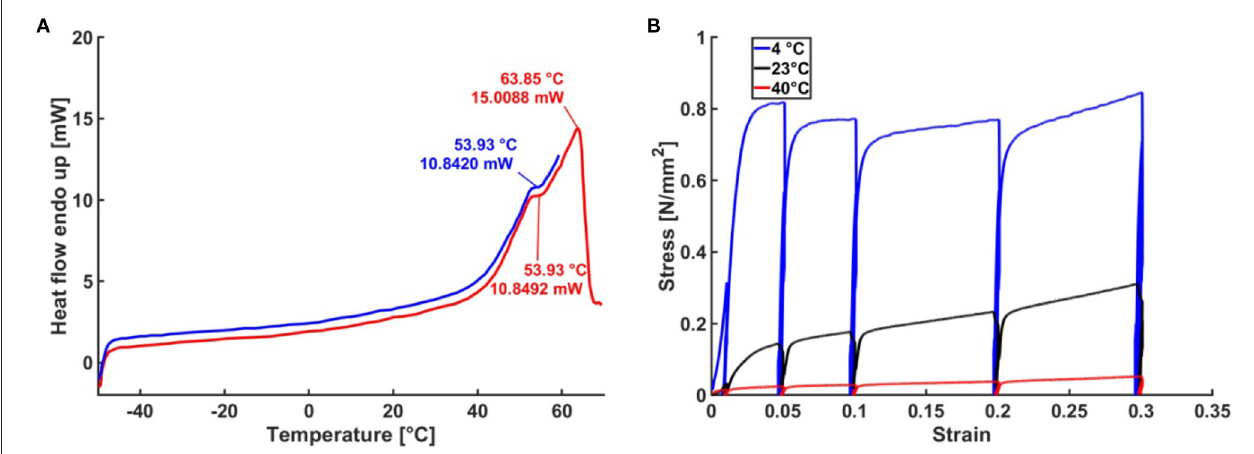
FIGURE 4 | Display of weighing experiments performed on propolis. The curve shows the mean weight of the samples ( N represents standard deviations at corresponding time points of